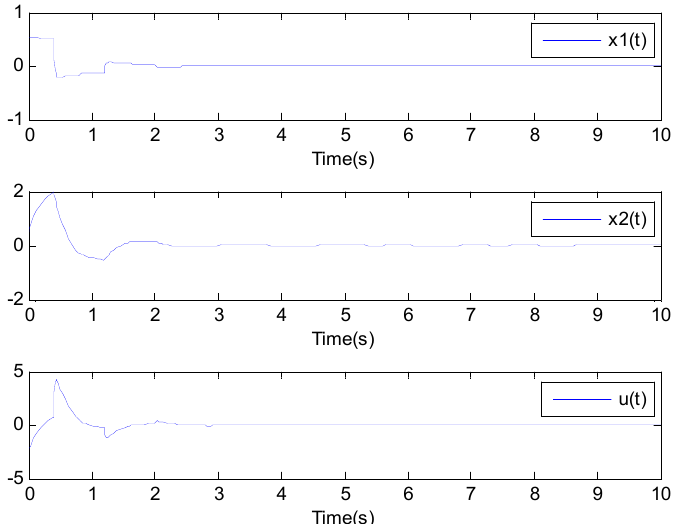
Figure 14. State variables evolution x 1 ( t ) , x 2 ( t ) and the controller u ( t ) ( a = 60, b = 15, m = 100, and δ = 0.4).